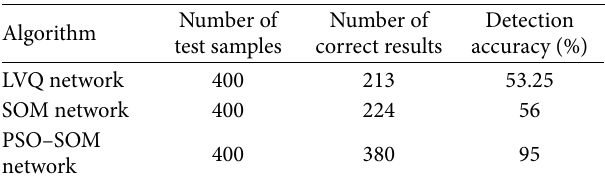
Table 8: Detection result